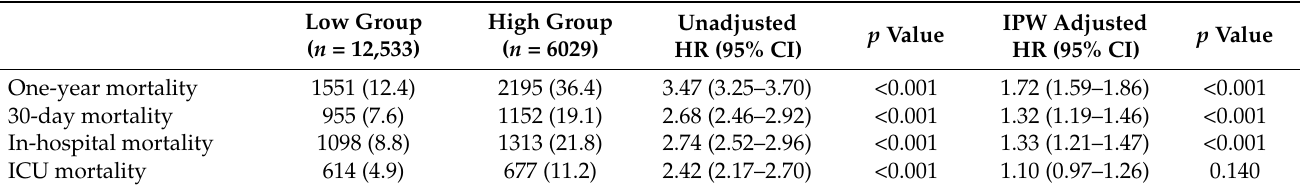
Table 3. Clinical outcome according to the estimated threshold of fibrinogen/albumin ratio of